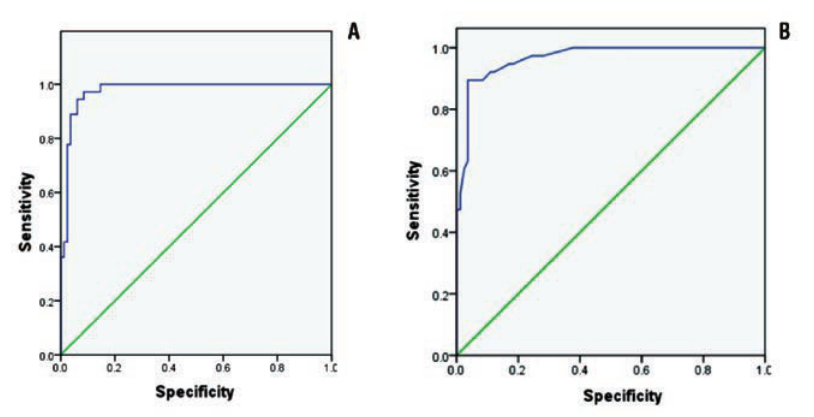
Figure 1. A receiver operator characteristic curve (ROC curve) of body mass index (A) and neck circumference (B) having obstructive sleep apnea induced